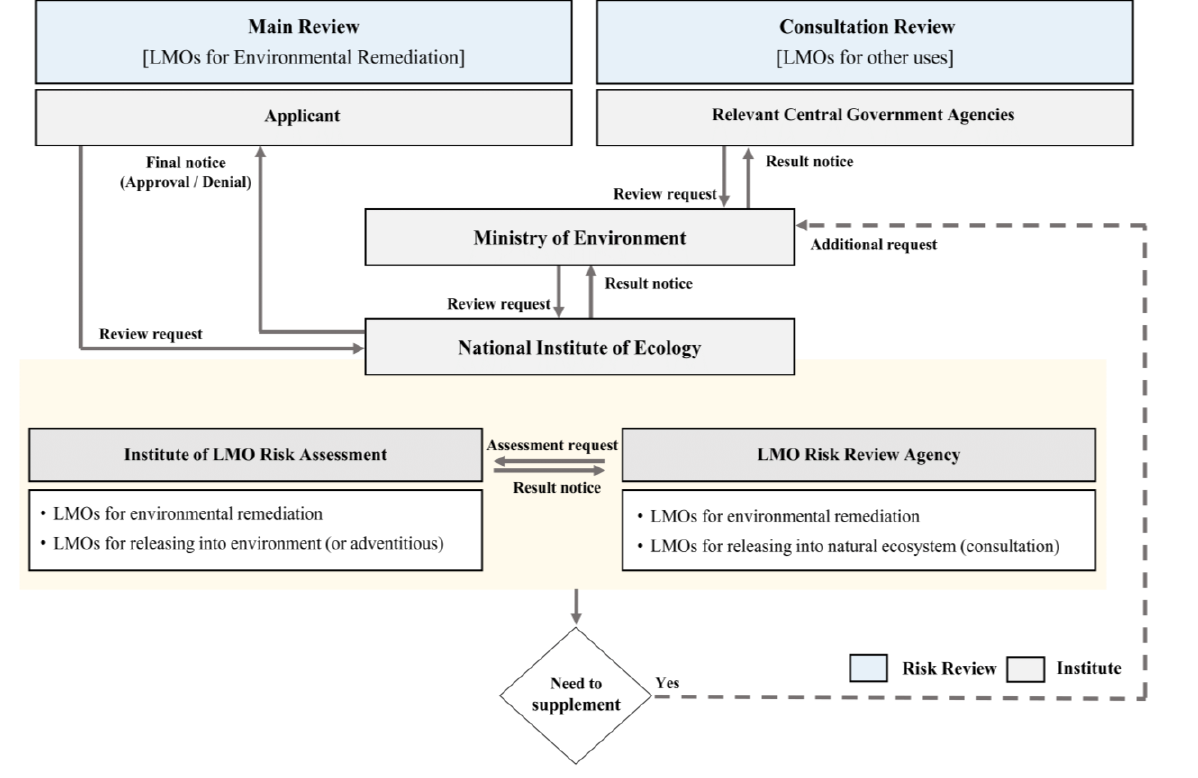
Figure 1. The safety-management framework of the Ministry of Environment and the National Institute of Ecology for LMO risk review and assessment.